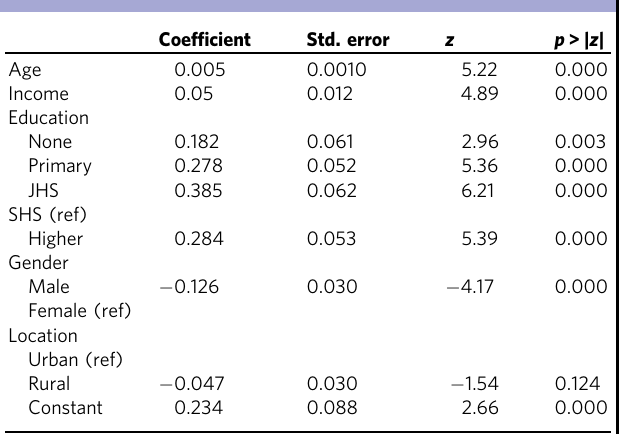
Table 6 The number of blocks in propensity